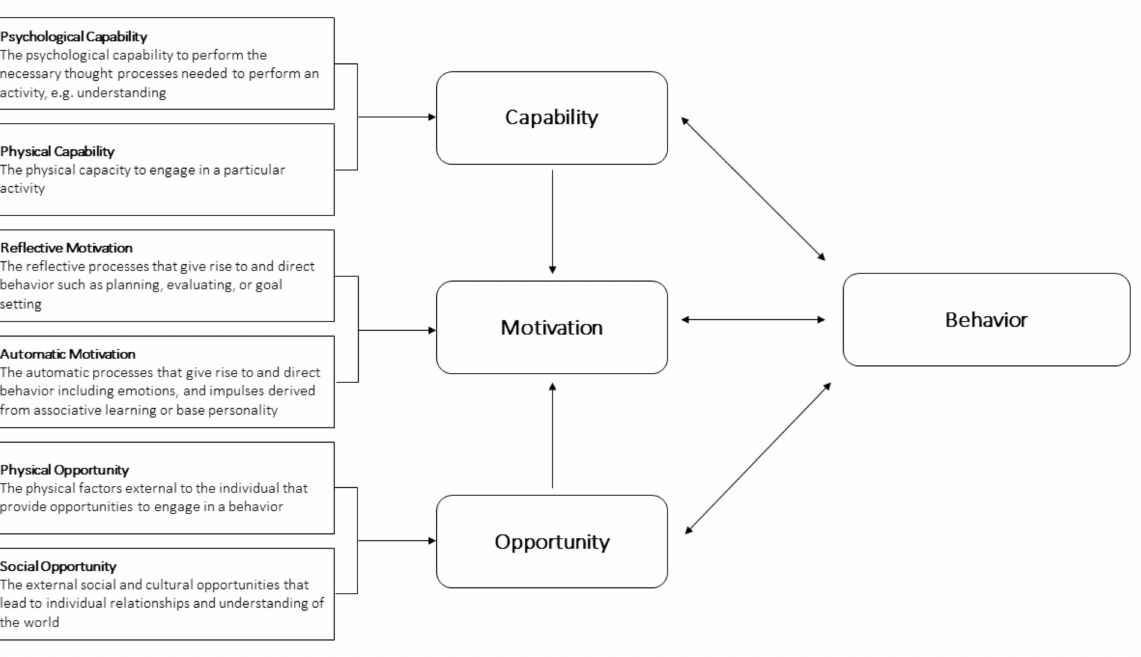
Figure 1. The interaction of the COM-B components and subcomponents within a behavioral system. Adapted from